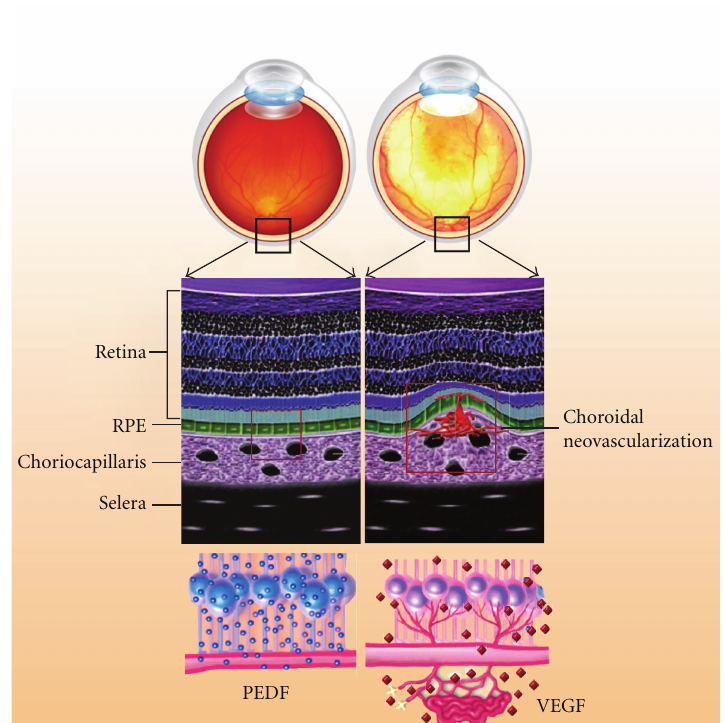
Figure 3: Schematic representation of choroidal neovascularization. PEDF was shown to prevent retinal cell death and counter the abnormal vessel growth induced by VEGF in the